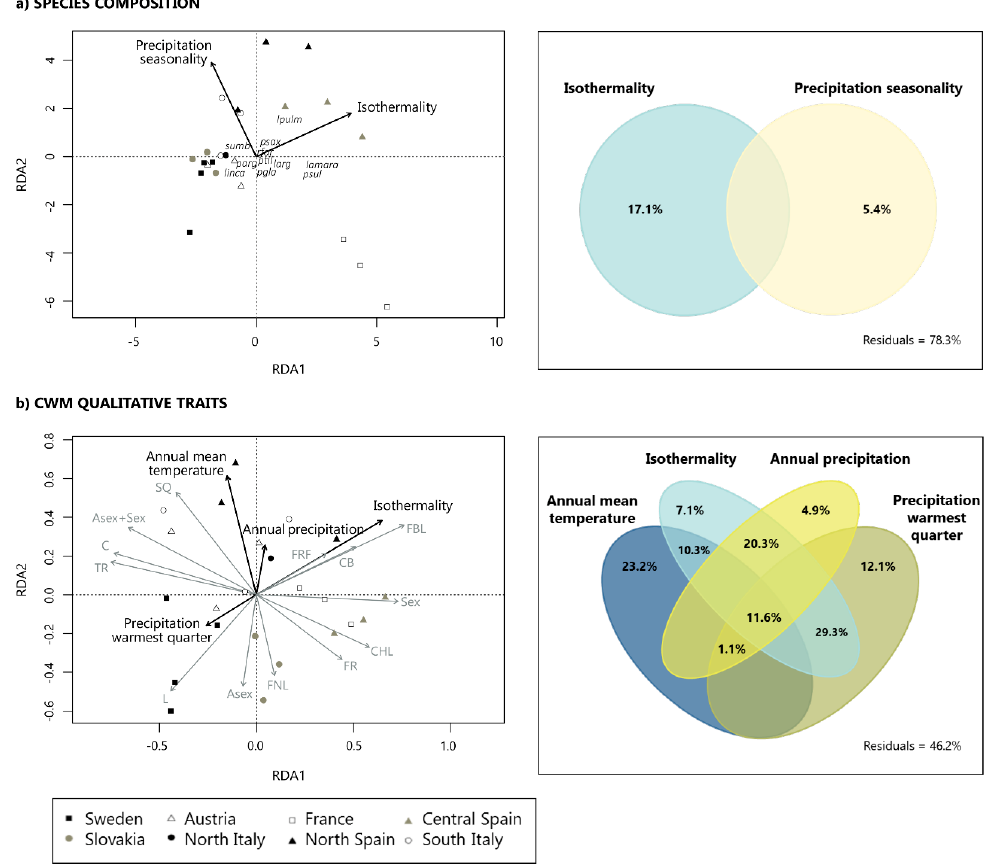
Figure 4. First two axes of the redundancy analysis ordinations (RDAs) and variation partitioning Venn diagrams representing the amount (%) of explained variation shared by different explanatory variables (intersection), and the percentage of the unexplained variation (residuals). Areas without values represent 0 or negative percentages of explained variance. ( a ) For species composition, the first two RDA axes explained 28.81% of the variance. ( b ) For CWM of qualitative traits, the first two RDA axes explained 62.19% of the variance. Only the climatic variables that significantly explained variability in lichen epiphytic community composition ( a ) and CWMs ( b ) following the forward stepwise procedure are shown (black arrows). Each point represents the lichen community at a specific forest ( n = 23) and the labels in italic denote the species with a higher weight on the ordination axis. Each grey arrow represents the CWM of the qualitative trait categories. The arrows direction indicates the maximum change of that variable, and the length is proportional to the rate of change. Abbreviations: (1) Species: larg = Lecanora argentata ; lamara = Pertusaria amara ; linca = Lepraria incana ; lpulm = Lobaria pulmonaria ; psax = Parmelia saxatilis ; psul = Parmelia sulcata ; ptil = Parmelina tiliacea ; parg = Phylctis argena ; pgla = Platismatia glauca ; rfar = Ramalina farinacea ; sumb = Scoliciosporum umbrinum ; (2) Traits: for growth form: C = crustose, SQ = squamulose, L = leprose, FBL = foliose broad lobed, FNL = foliose narrow lobed, FR = fruticose, FRF = fruticose filamentous; for photobiont: CB = cyanolichen, CHL = chlorolichen, TR = Trentepohlia ; for reproduction: Asex = asexual, Sex = sexual, Asex + Sex = with asexual and sexual